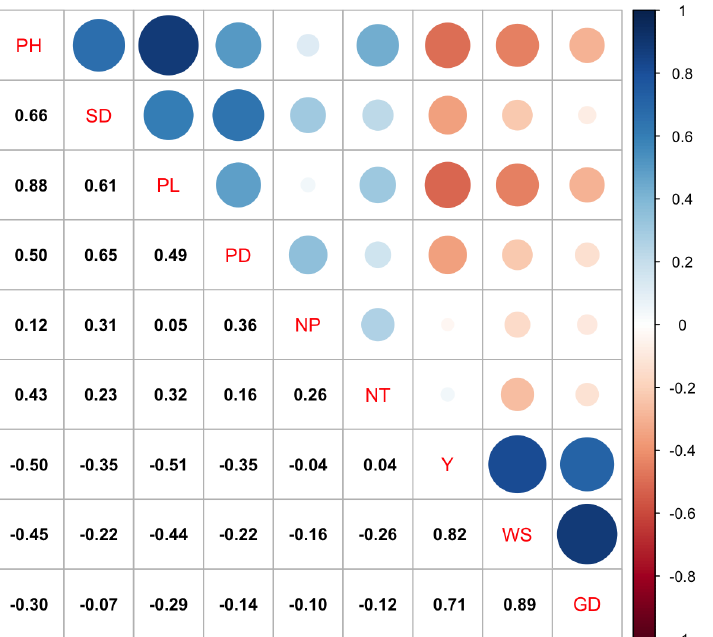
Figure 1. Spearman correlation analysis among the quantitative variables in the 30 quinoa